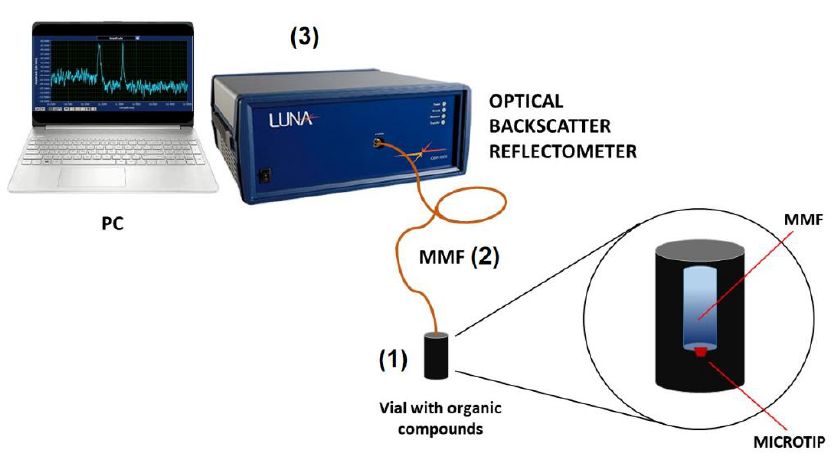
Figure 4. Measurement set-up of the VOC sensor: (1) glass vial with VOC, (2) MMF 105, and (3) OBR with PC.